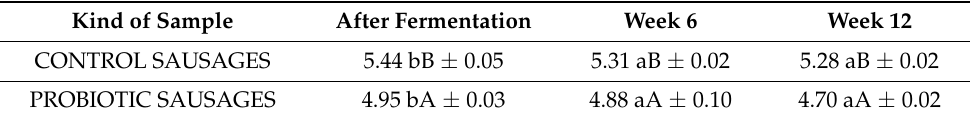
Table 2. pH values of dry fermented pork sausages after fermentation after 6 and 12 weeks of storage.